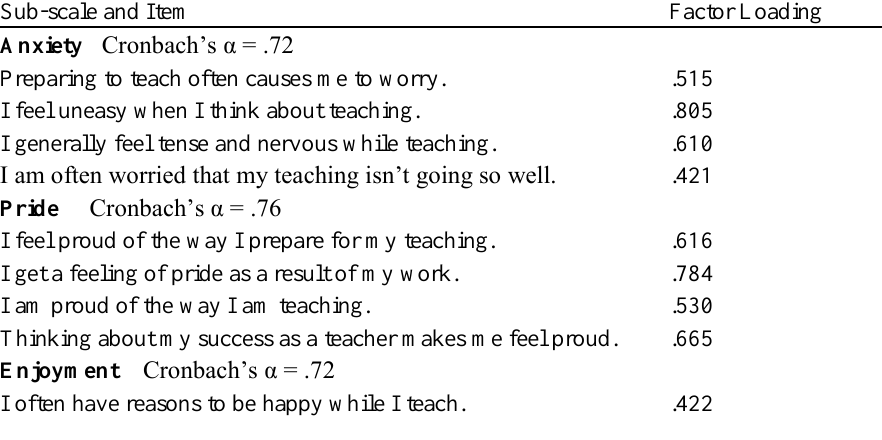
Confirmatory Factor Analysis Results for Factor Loading on the Revised AEQ-T Scale (Korean Sample) Sub-scale and Item Anxiety Cronbach’s α =